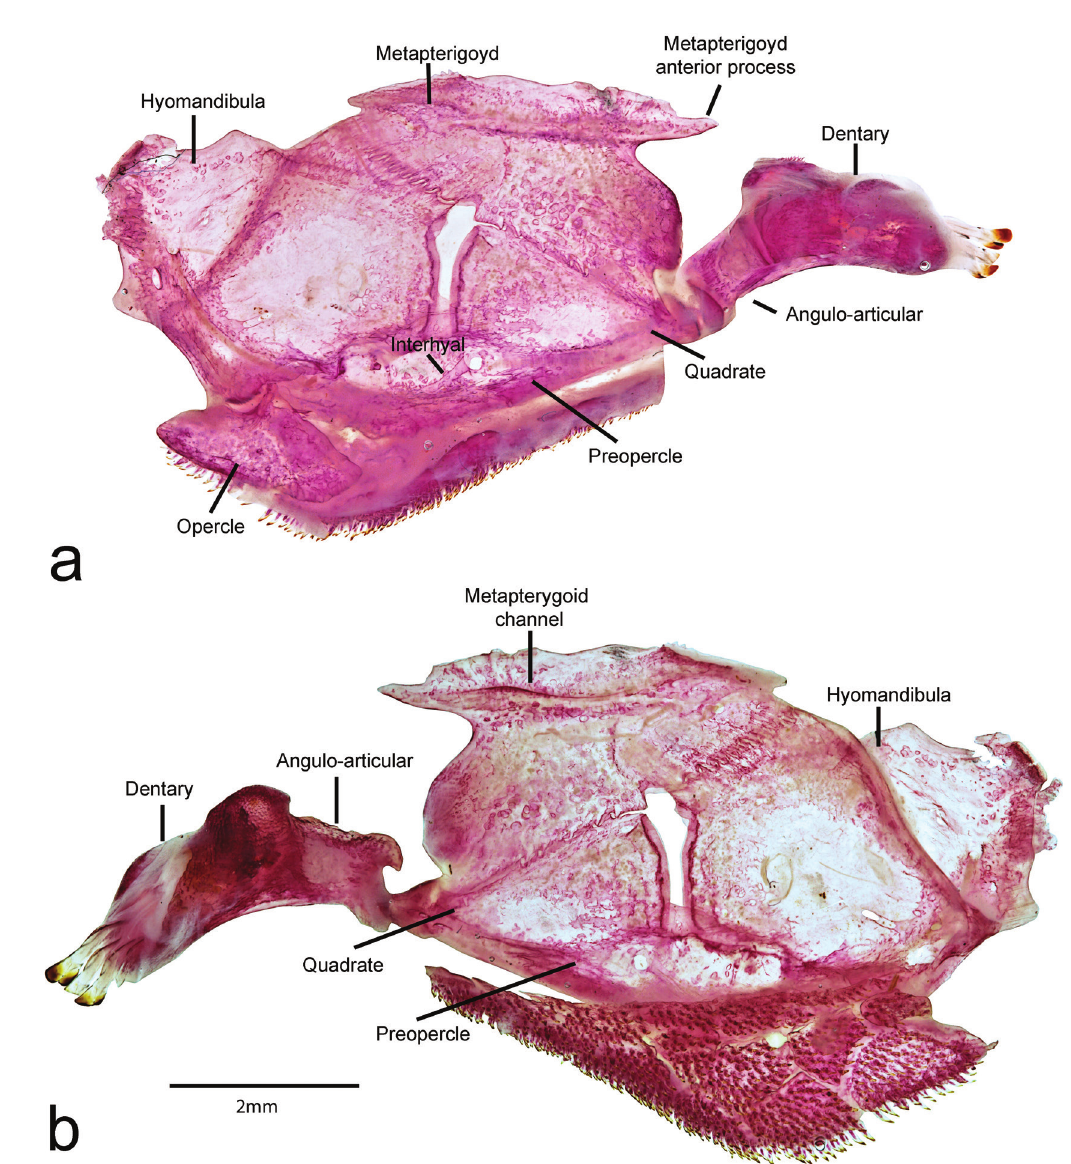
Fig. 4. Suspensorium of Spectracanthicus murinus , MZUSP 24293, 37.0 mm SL. a. internal view; b. external view. Scale bars = 2 mm. Image by E.